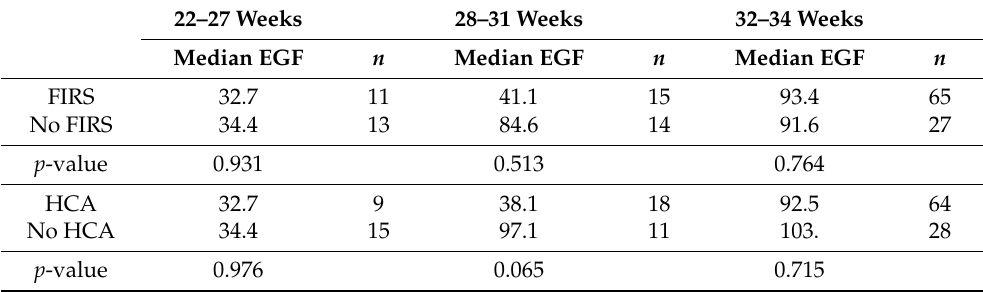
Table 3. Fetal inflammatory response syndrome (FIRS) and histological chorioamnionitis (HCA) effects on median EGF concentrations (pg/mL) in gestational age